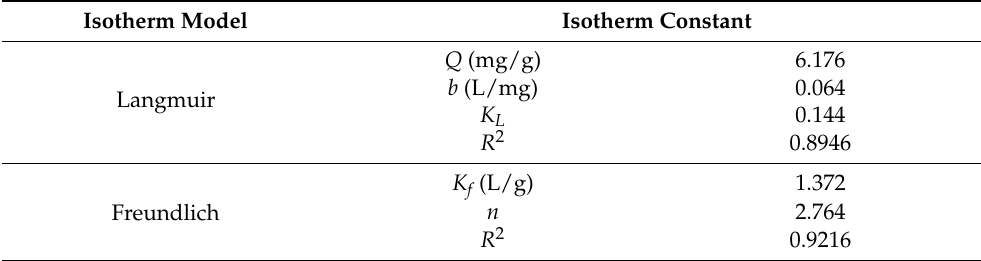
Table 6. Isotherm constants. Isotherm